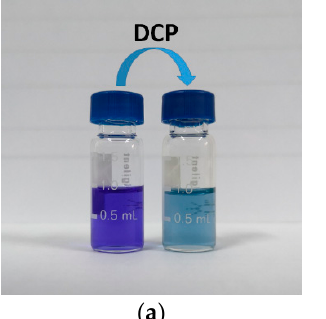
Figure 6. Color change of the CV solution ( a , 2 μ g/mL) and CV-SiO 2 gel film ( b ).